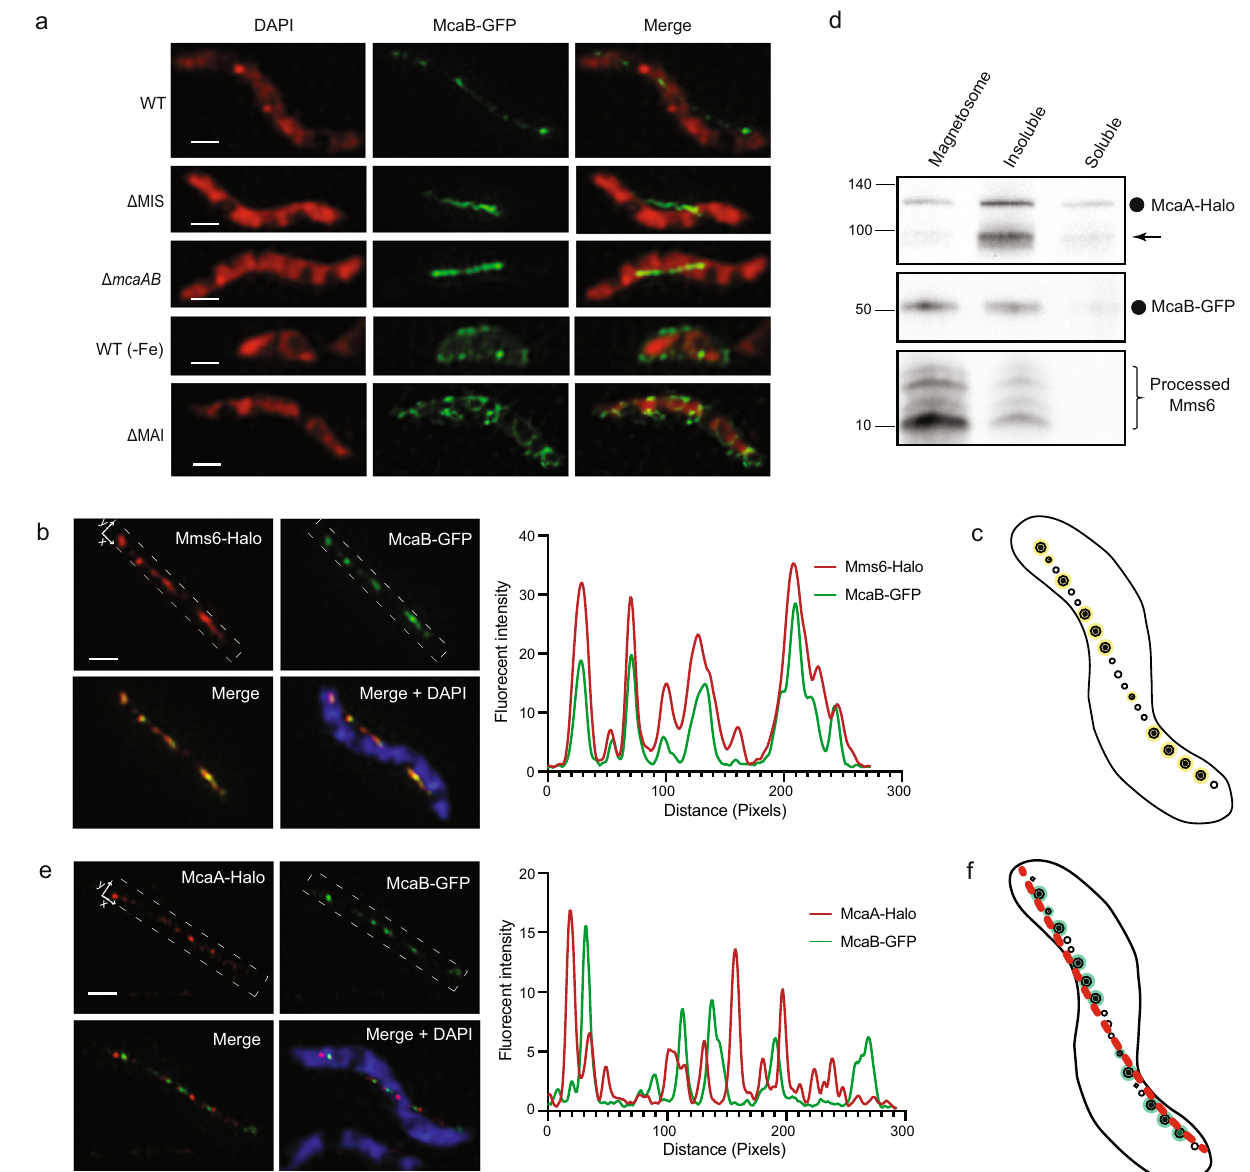
Fig. 5 | Localization of McaB. a Representative maximum-intensity projection of 3D-SIM micrographs shows the localization of McaB-GFP in WT and different genetic backgrounds. The DAPI staining is shown in false-color red and the GFP fusion proteins are shown in green. b Representative maximum-intensity projec- tion of 3D-SIM micrographs and fl uorescent intensity map (white dashed rectan- gular area)showthe localization ofMms6-Haloand McaB-GFPin WT. c A model of the colocalization (yellow) of Mms6 and McaB at CMs from b . d Immunoblotting shows that McaA and McaB are enriched in different cellular fractionations. McaA- Halowasdetectedwithanti-Haloantibodies,McaB-GFPwasdetectedwithanti-GFP antibodies, and Mms6 was detected with anti-Mms6 antibodies. Full-length McaA-